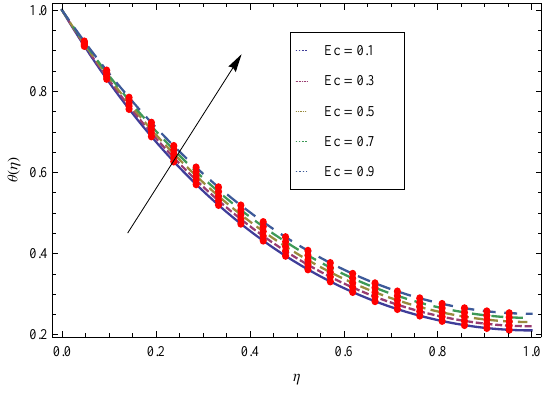
Figure 16. Shows the effect of Sc on φ ( η ) , for h = − 0.6, λ = 0.5, S = 0.5,kr = 0.5,Pr = 0.5,Ec = 0.5, Nb = 0.5,Nt = 0.5, β = 1 and Sc = 0.6.